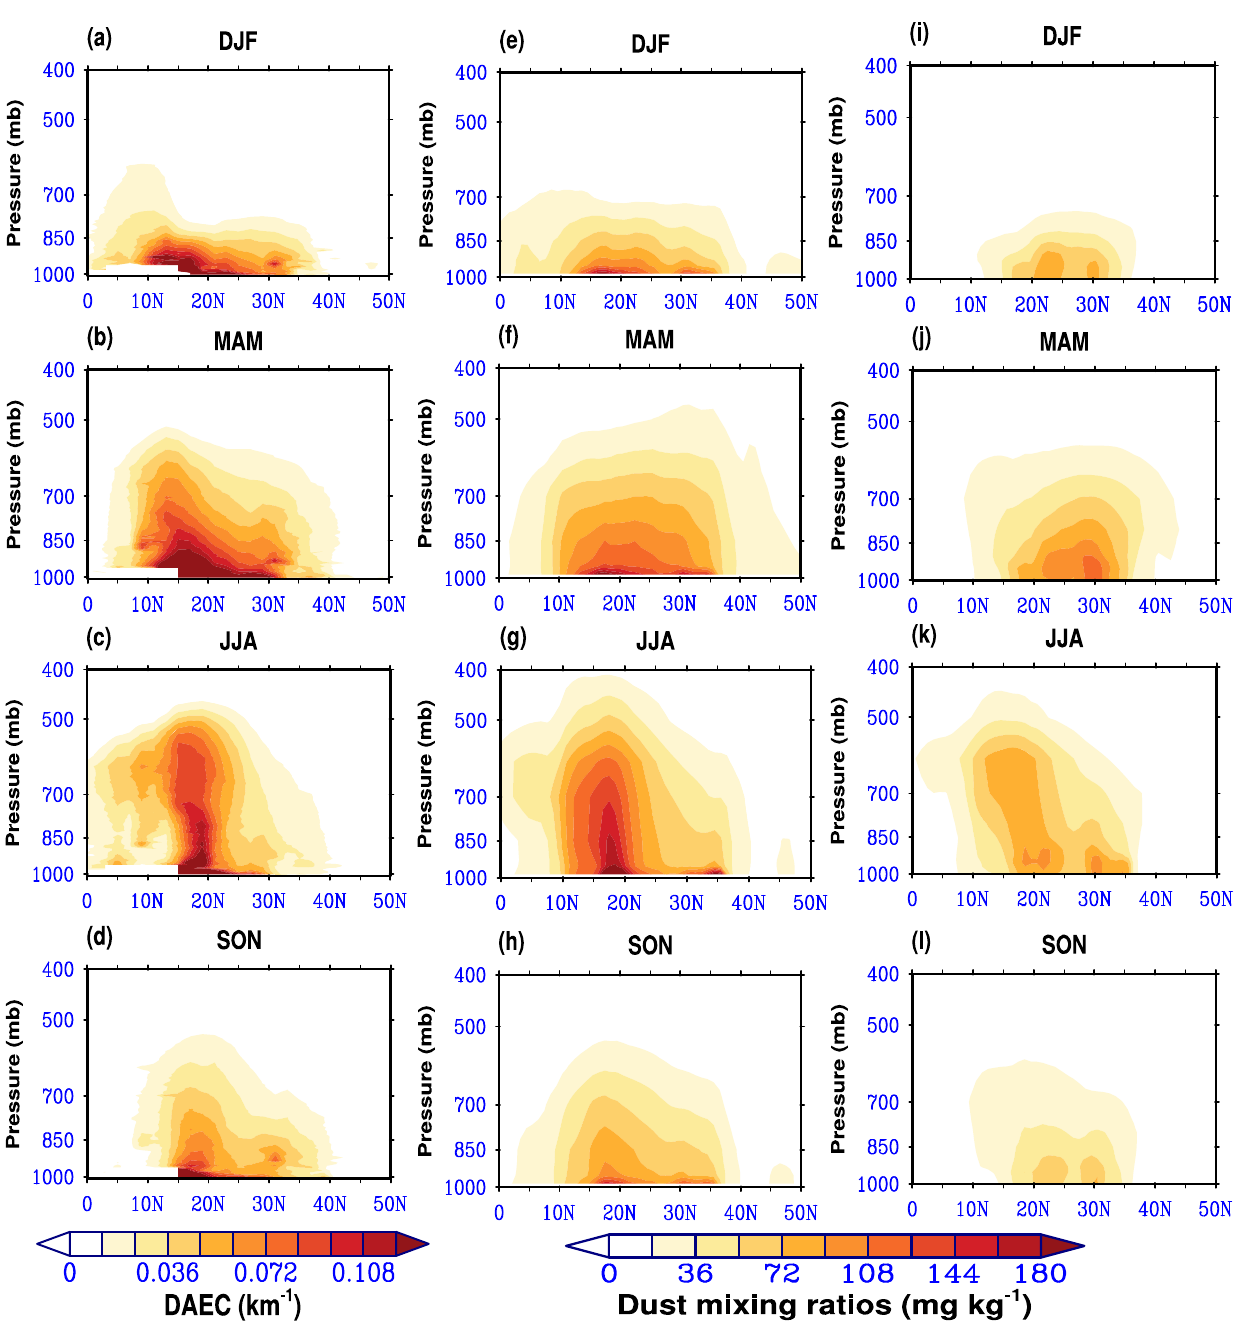
Fig. 3 Zonal climatology of dust aerosol distribution over Red Sea. Seasonal zonal climatology of Dust aerosol extinction from CALIOP ( a – d ), and dust mixing ratios from MERRA-2 ( e – h ) and CAMS ( i – l ) over the Red Sea (zonally averaged between 33°E and 43°E) during the period 2007 –